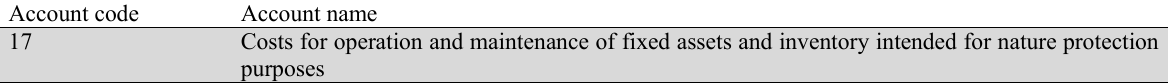
Excerpt from the Plan of Accounts: accounting of costs for acceptance, storage and disposal of hazardous wastes Account code